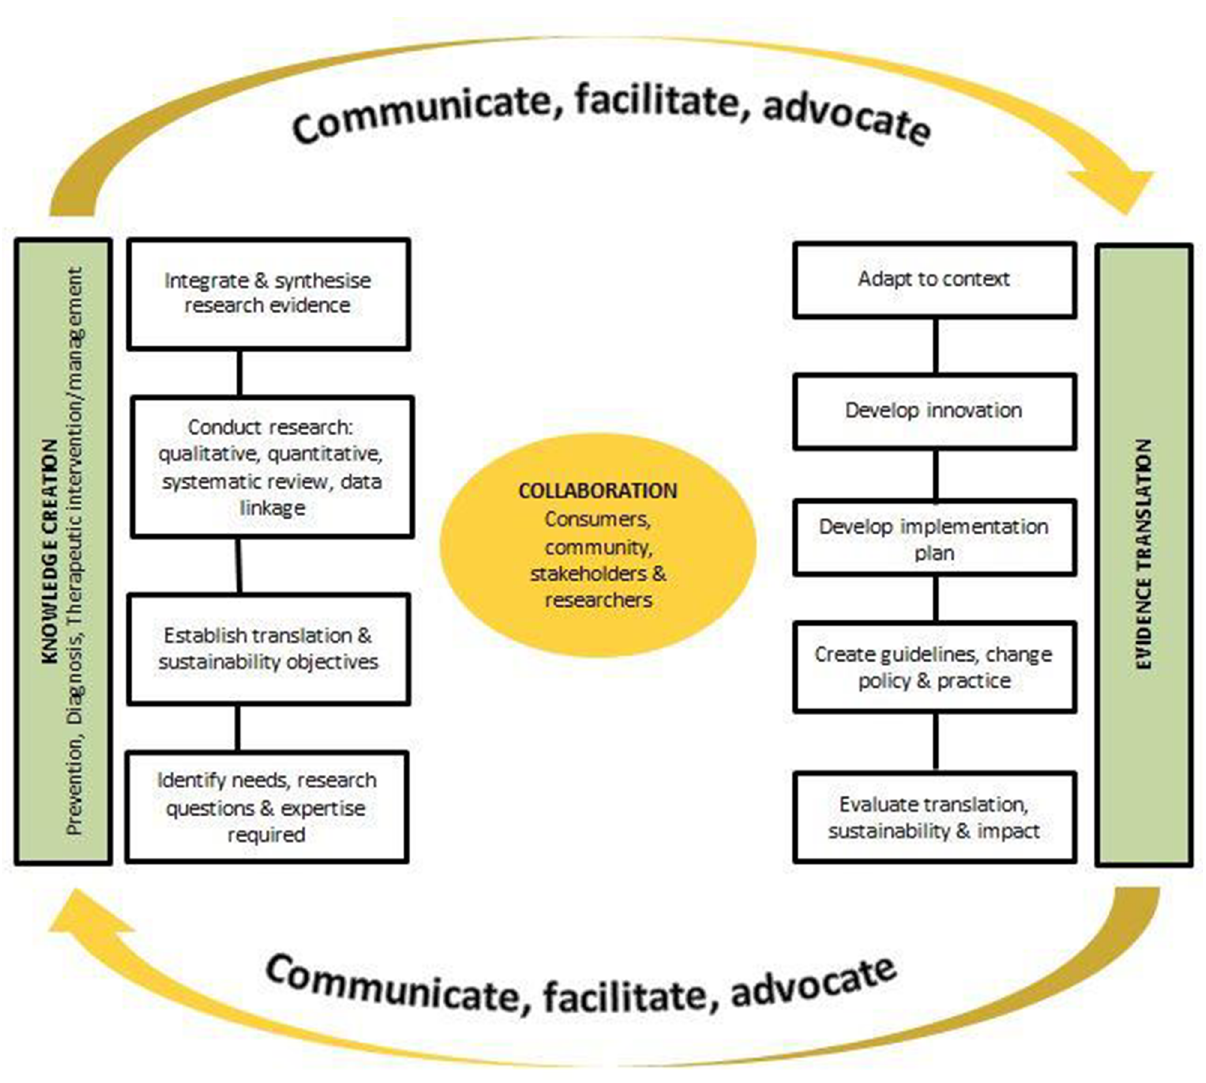
Figure 1: FASD Research Australia, NHMRC Centre of Research Excellence: approach to policy and practice